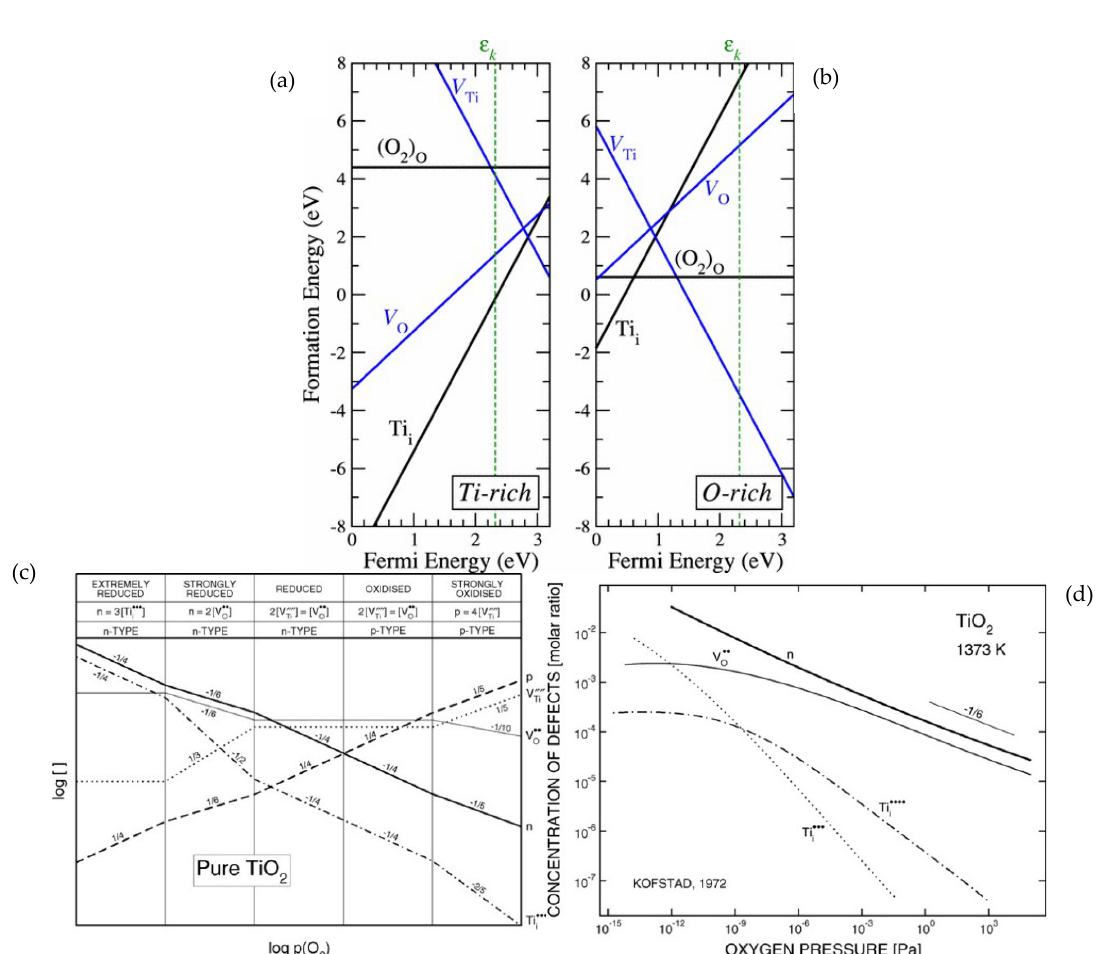
Figure 4. ( a ) DFT—calculated defect formation energies in Titania as a function of fermi energy (E F ) under Ti-rich and ( b ) O-rich growth conditions. Reproduced from [56], Copyright 2006, The American Physical Society. ( c , d ) Variation in defect concentration under different oxygen pressure conditions [57,58]. Reproduced from [57], Copyright 2008, American Chemical Society.